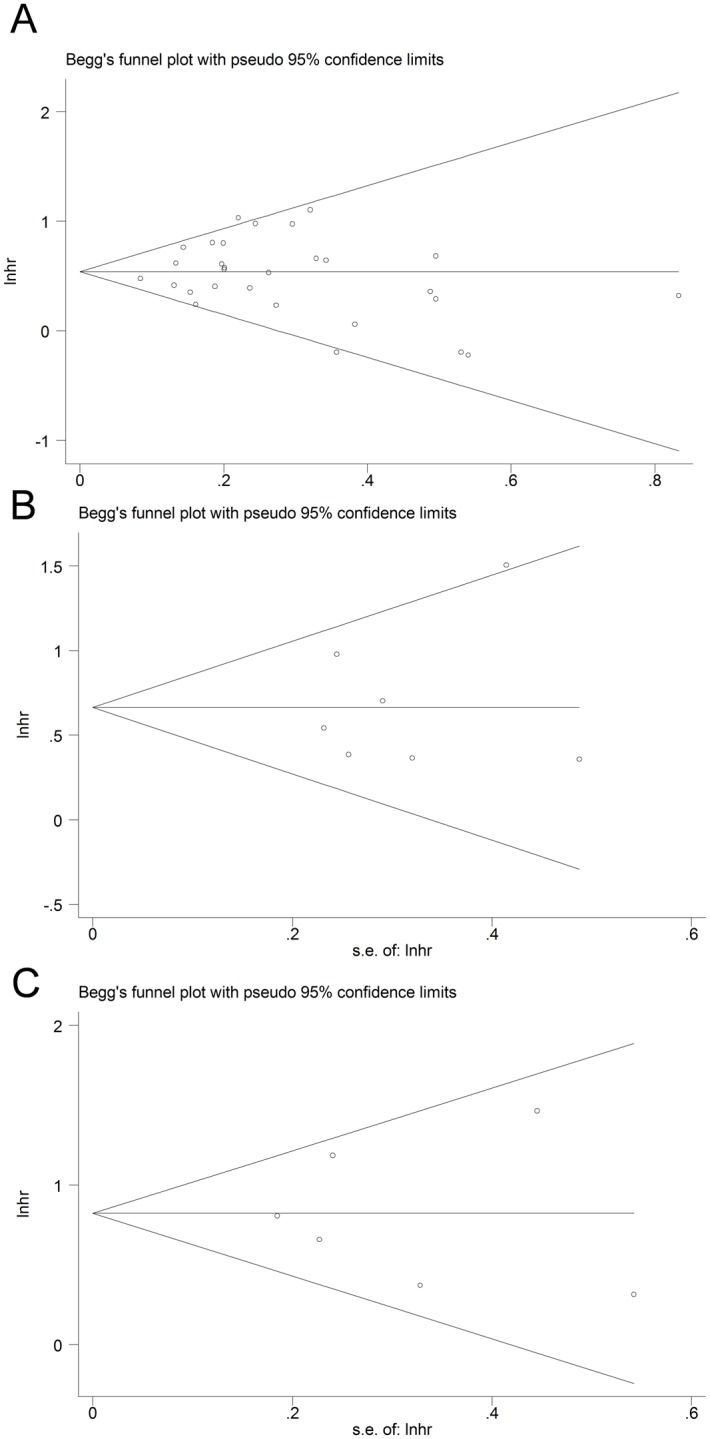
Funnel plots to evaluate publication bias of OS (A), DSS (B) and DFS (C).